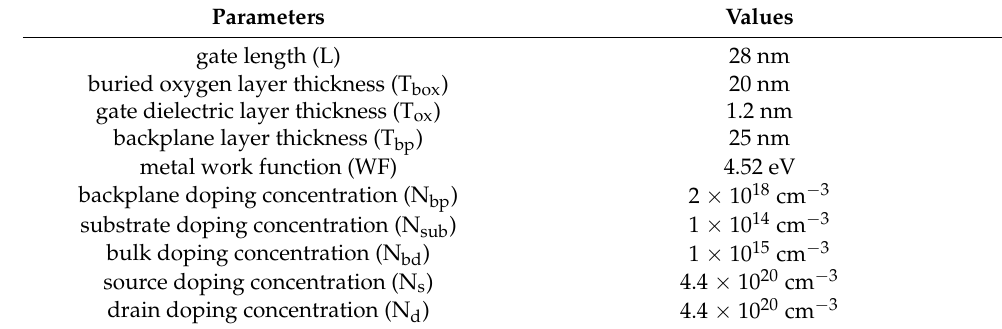
Table 1. FDSOI device parameters.